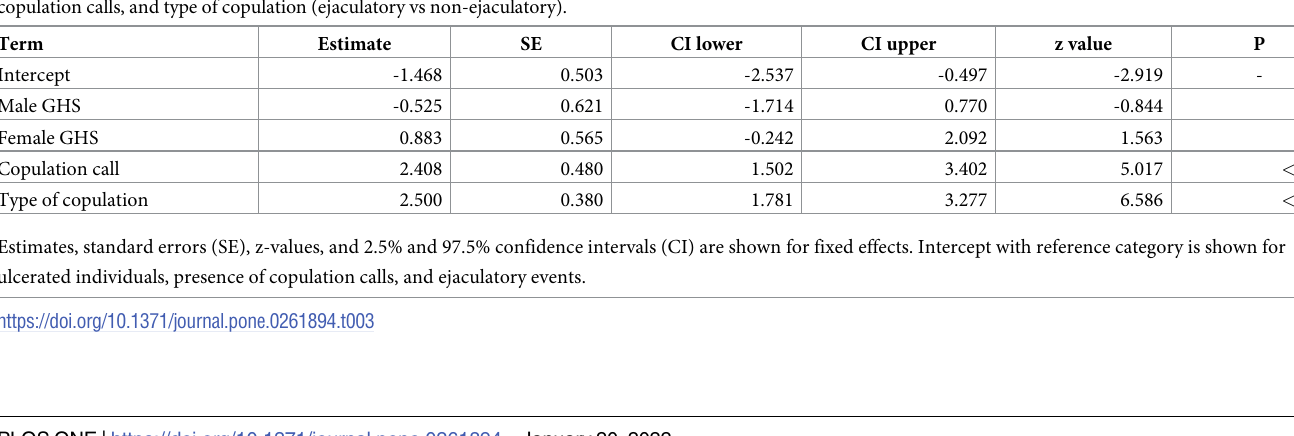
Estimates, standard errors (SE), z-values, and 2.5% and 97.5% confidence intervals (CI) are shown for fixed effects. Intercept with a reference category is shown for ulcerated individuals and ejaculatory events.